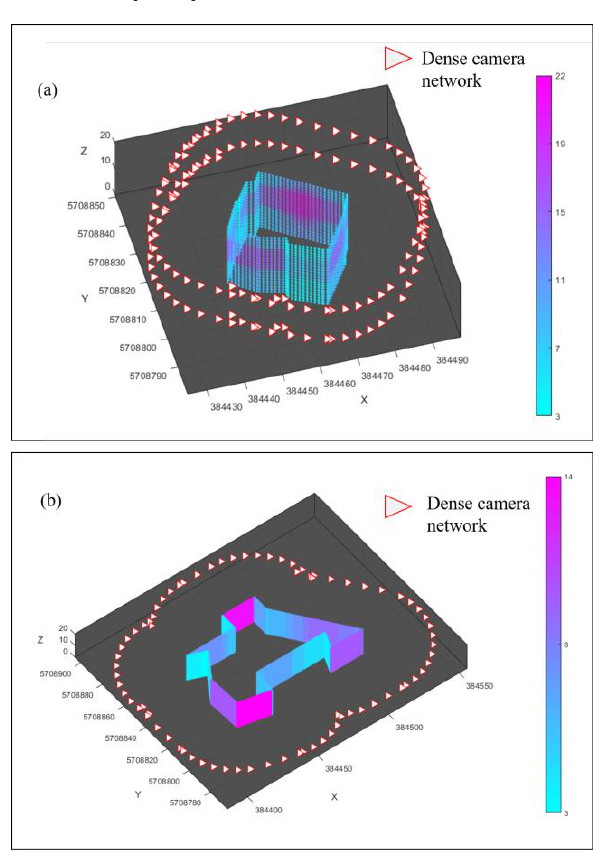
Figure 6 Number of images in which each point is visible (a) real (b) synthetic building in dense camera network The visibility of each point of the building façade in the dense camera network was verified. This type of visibility check was quick for sparse point cloud of approximately 10,000 points.